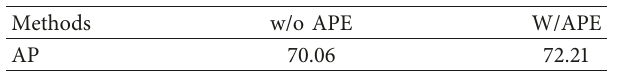
Table 1: Experimental results on adjustable periodic coding (APE) during region generation on DOTA’s verification set.